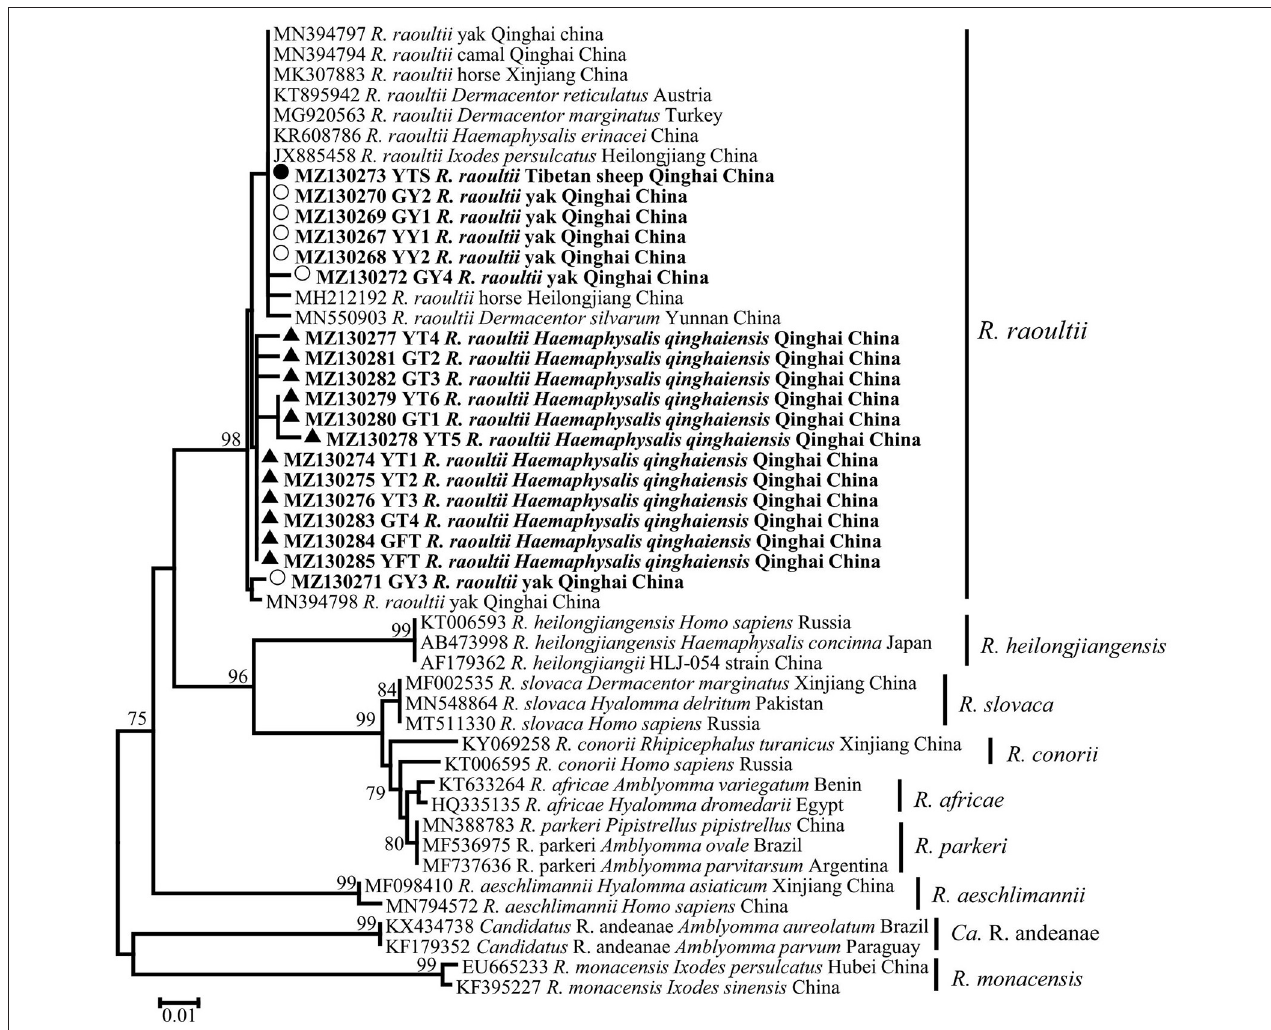
FIGURE 4 | Phylogenetic tree based on ompA particle sequences (209/212 bp) of spotted fever group (SFG) Rickettisa obtained in this study. Bootstraps analysis was performed with 500 replicates. The solid circle indicates sequences from Tibetan sheep, the empty circle indicates sequences from yaks, and the solid triangle indicate sequences from Haemaphysalis qinghaiensis . All sequences from this study are